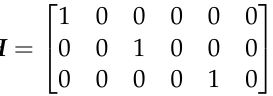
i , i , (cid:101) Y ) in BAF, fused 3D t , k (cid:48)(cid:48) c ,3 D t , k (cid:48)(cid:48) c ,3 D ,(cid:2871)(cid:3005)(cid:3036),(cid:3036) , 𝒀(cid:3561) ,(cid:2871)(cid:3005)(cid:3036),(cid:3036) ) in BAF, , C i ) in t , k c ,3 D (cid:3047),(cid:3038) (cid:3278)(cid:4594)(cid:4594) (cid:3047),(cid:3038) (cid:3278)(cid:4594)(cid:4594) t , k c ,3 D ,(cid:2871)(cid:3005)(cid:3036) , 𝑪 ,(cid:2871)(cid:3005)(cid:3036) ) in SA-PF. (cid:3047),(cid:3038) (cid:3278) (cid:3047),(cid:3038) (cid:3278)